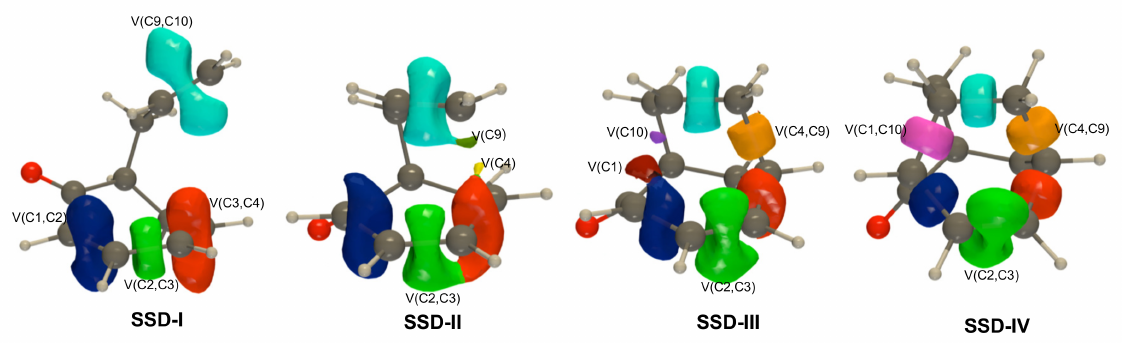
Figure 5. ELF basin isosurfaces ( η = 0.7) of each of the SSDs found along the IRC associated with TS2-b Color labeling of the basins is adopted according to Figure